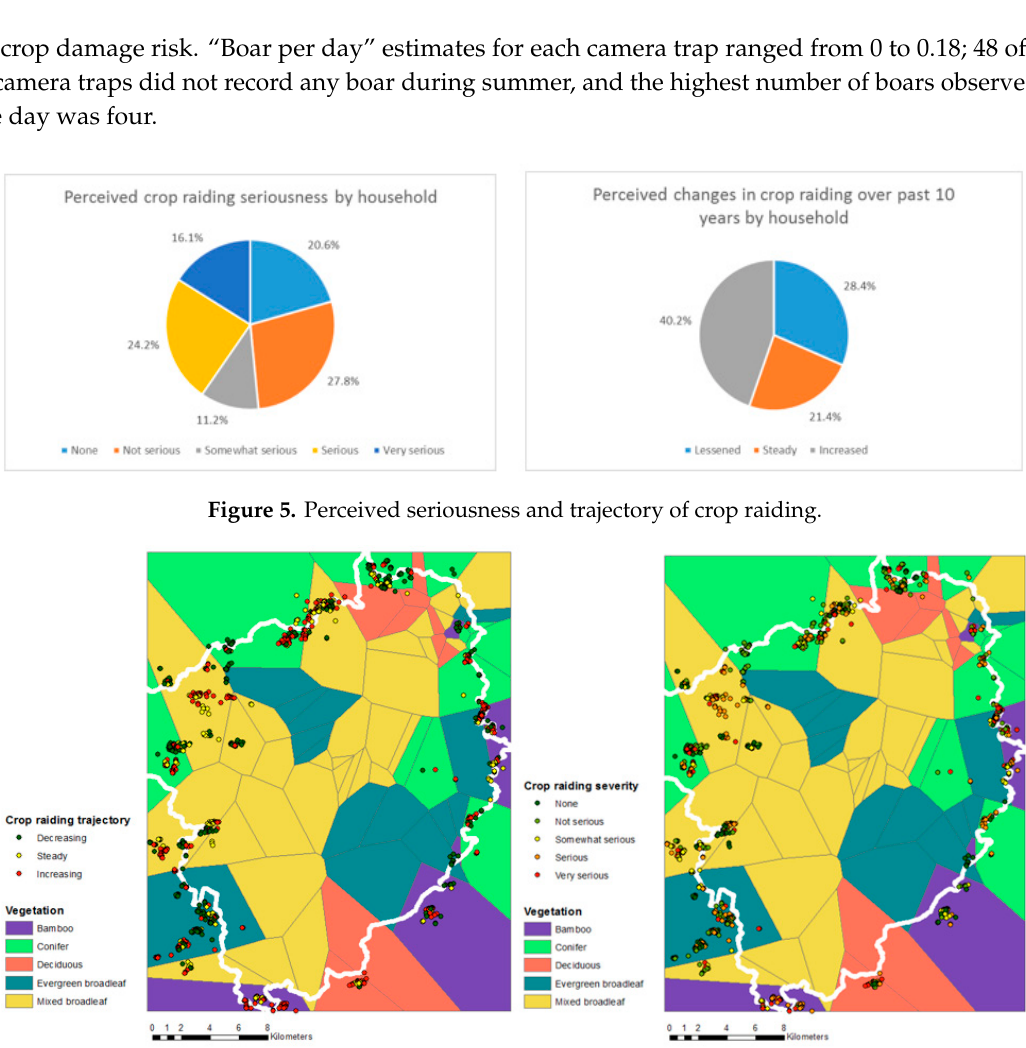
Figure 6. Household perceptions of crop raiding throughout the region.